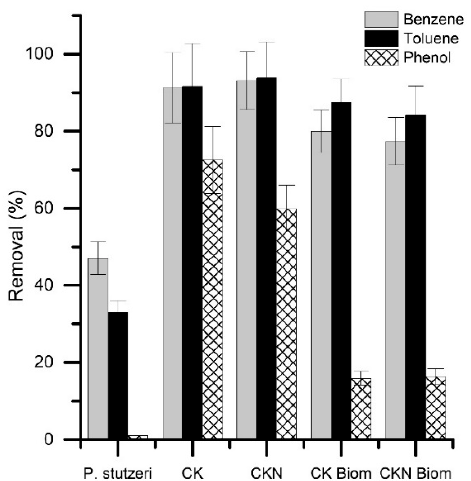
Figure 6. Aromatic hydrocarbon removal by activated carbons prepared by chemical activation of olive stones with potassium hydroxide (CK), functionalized with melamine (CKN), P. stutzeri on CK (CK Biom.) and CKN (CKN Biom.) materials.